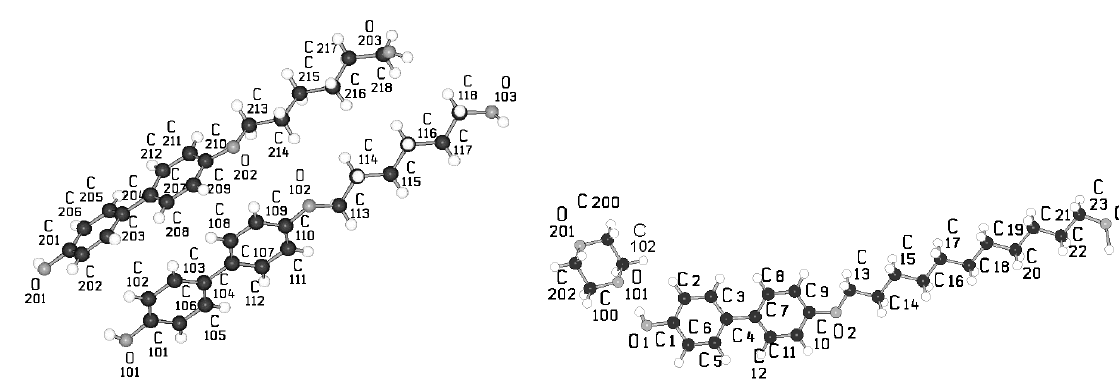
Summary of crystallographic data for the homologous series